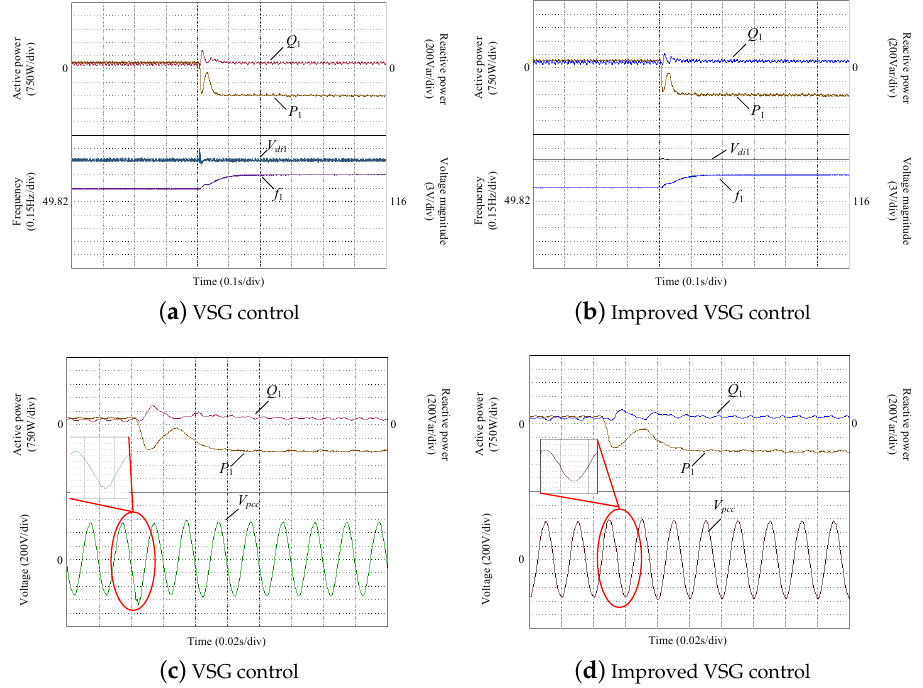
Figure 5. Waveforms of microgrid when DG3 is connected to DG1.